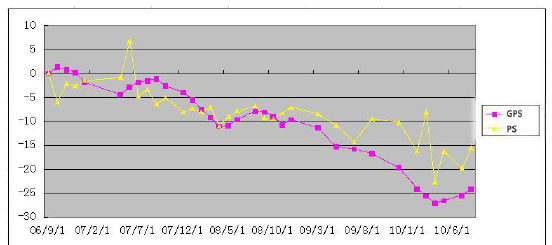
Figure 6 The subsidence rate of GPS and